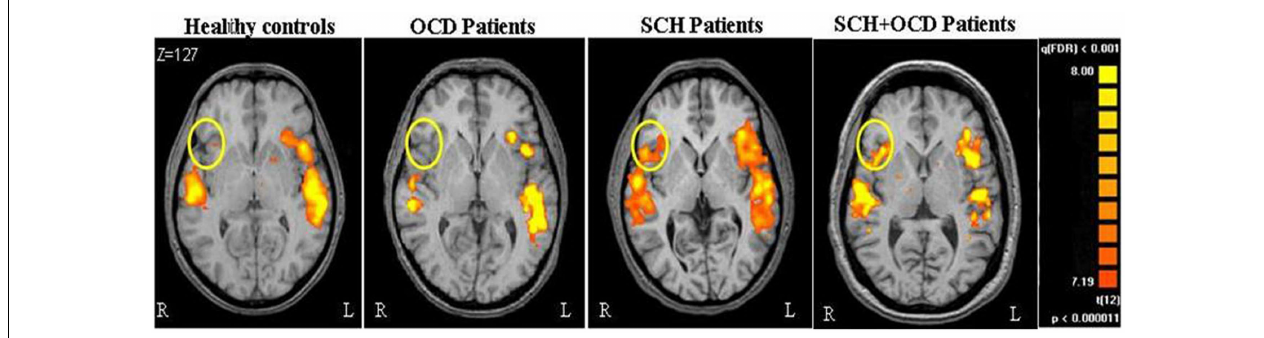
FIGURE 1 | Brain activation during language task is shown . Axial views of parametric activation maps obtained during language tasks for the all groups. Colored regions indicate greater activation duringVG than during periods of rest (FDR p < 0.001; random